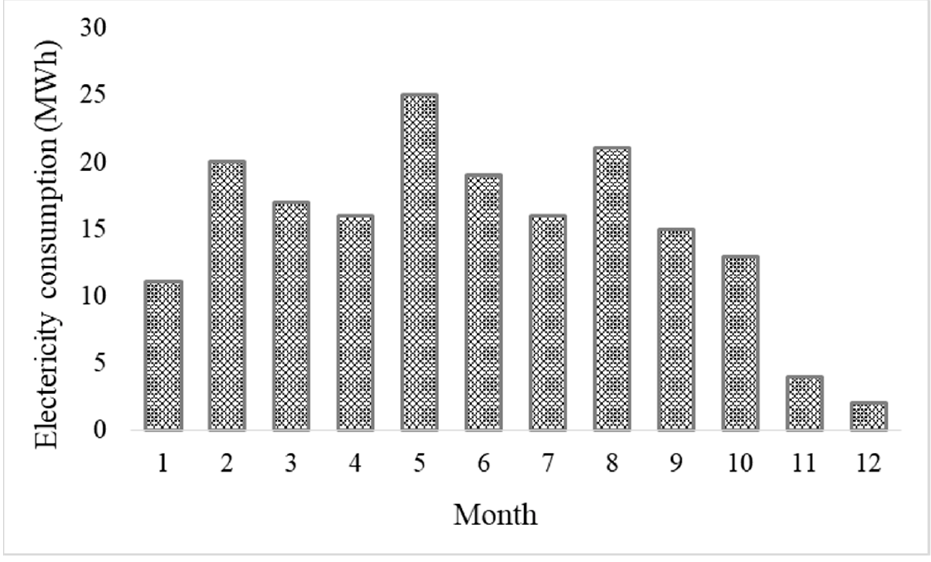
Figure 5. Monthly electricity consumption profile of the single shrimp farm.